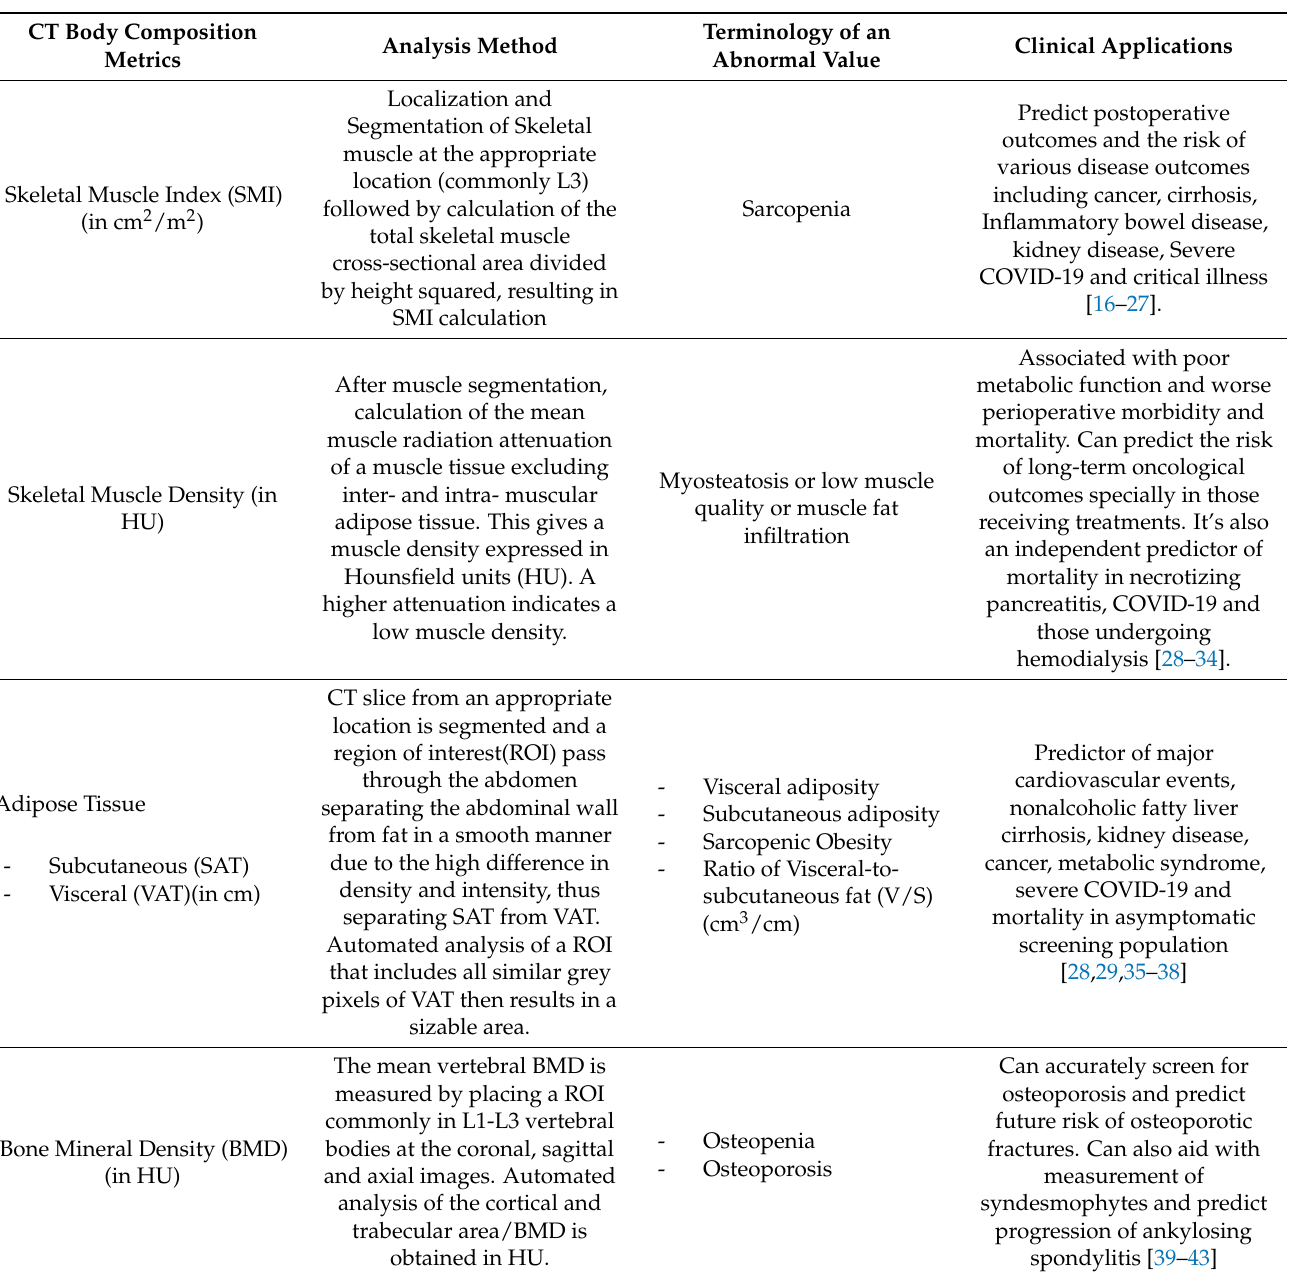
Table 1. Summary of the standard metrics analyzed from CT body composition: Several metrics can be obtained from CT body composition analysis using unique ways of technical calculations. Slice identification is commonly done with the support of DenseNet or ResNeXt which is a multi-class natural image classification architecture that can help find the optimal slice. CT body composition analysis is then performed using a tissue segmentation model, commonly based on the U-Net model which is highly effective for medical image segmentation. Each metric has an important value in the clinical arena guiding risk prediction and prognostication with the potential to optimize patients